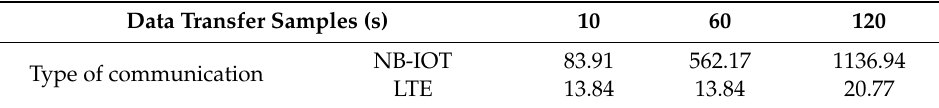
Table 2. Communication cost for PMU data transfer ($ / month).